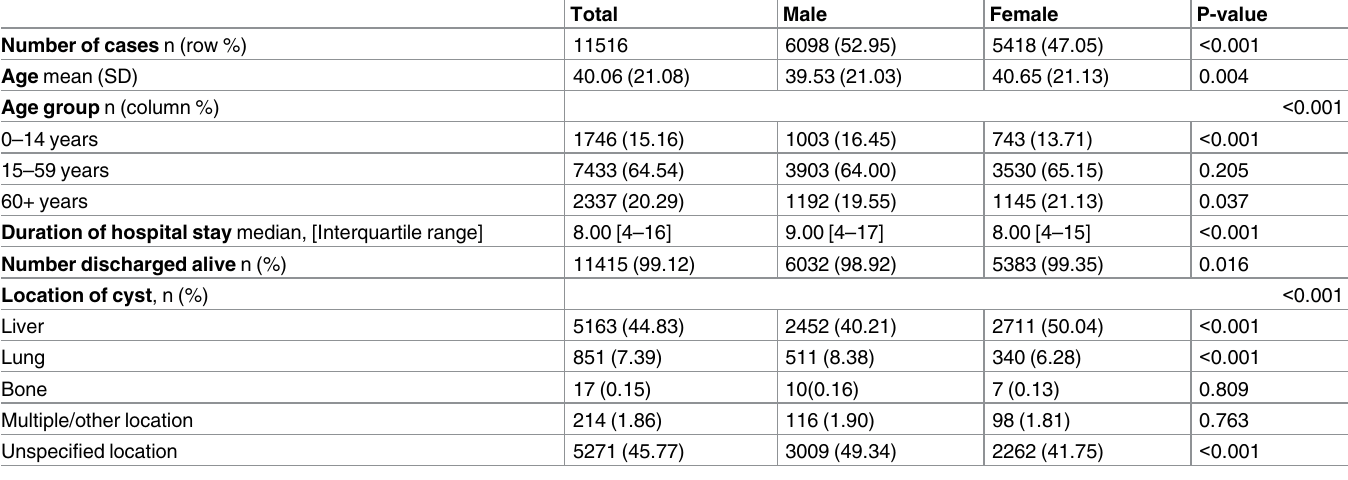
Table 1. Characteristics of patients hospitalized for echinococcosis from 2001 to